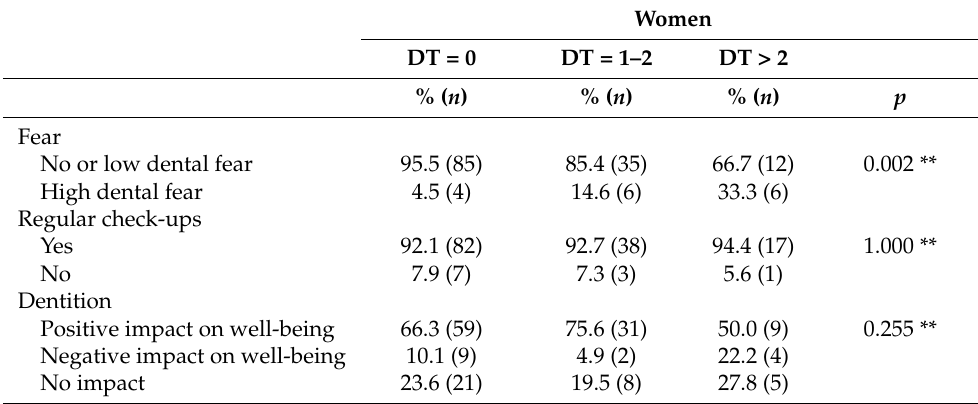
Table 3. Distribution of women participants according to categorised DT values, dental fear, self- reported regularity of check-ups and dentition-related